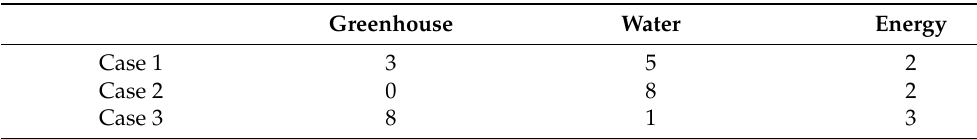
Table 3. Case study combinations according to weights assigned [1,10] for the attributes of each supplier.